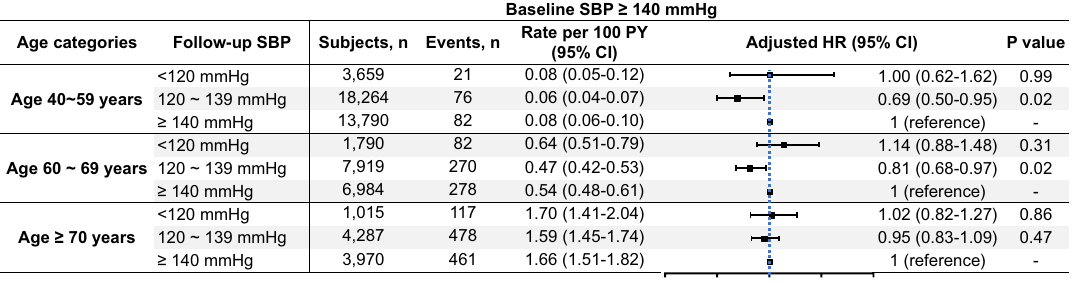
Figure 6. ( A ) Adjusted HR for risk of dementia according to delta SBP in patients with uncontrolled (≥ 140 mmHg) baseline SBP. Delta SBP was defined as follow-up SBP minus baseline SBP. Subjects with delta SBP = 0 mmHg were used as reference. ( B ) Event rates and adjusted HR for risk of dementia according to follow-up SBP in patients with uncontrolled (≥ 140 mmHg) baseline SBP. Rates are per 100 person-years. Subjects with continuously uncontrolled hypertension (follow-up SBP ≥ 140 mmHg) were used as reference. Spline curves represent HRs adjusted same as Fig. 3. Abbreviations as in Fig.